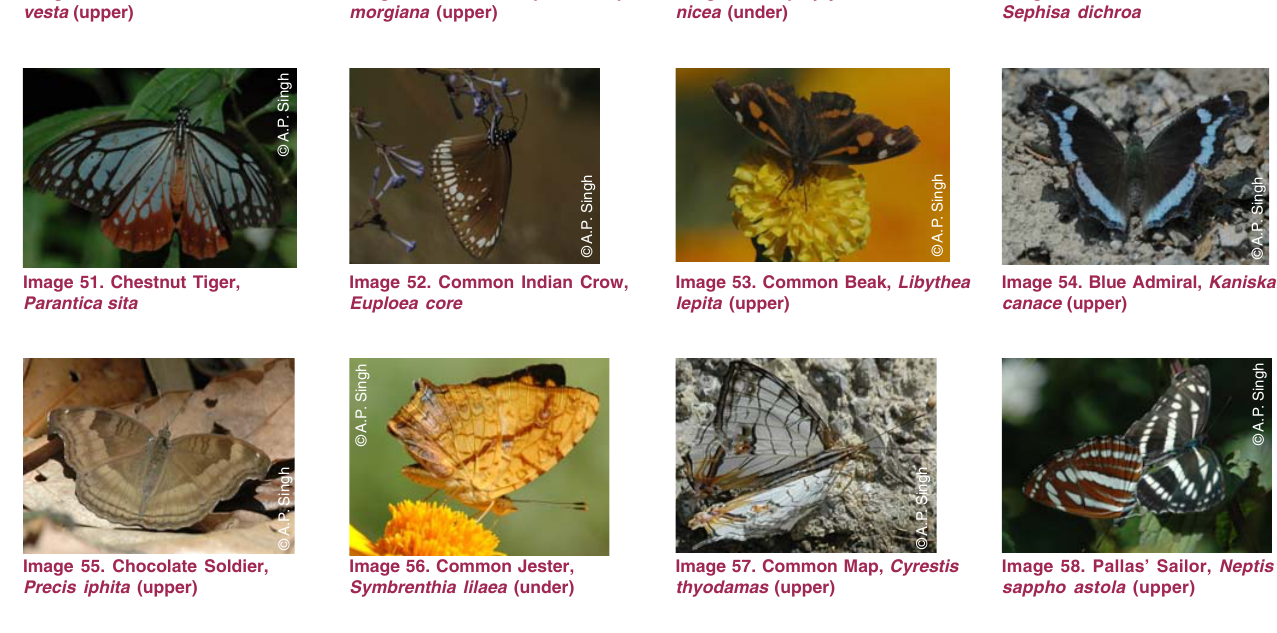
(upper)Image 47. Yellow Coster, Pareba vesta (upper)